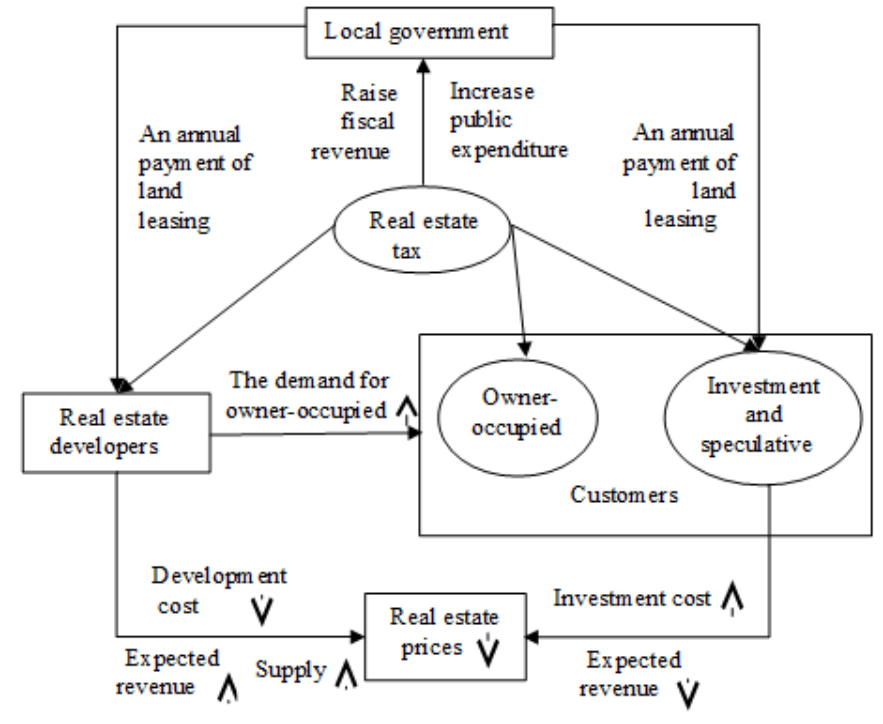
Figure 1. The impact of the real estate tax on the real estate